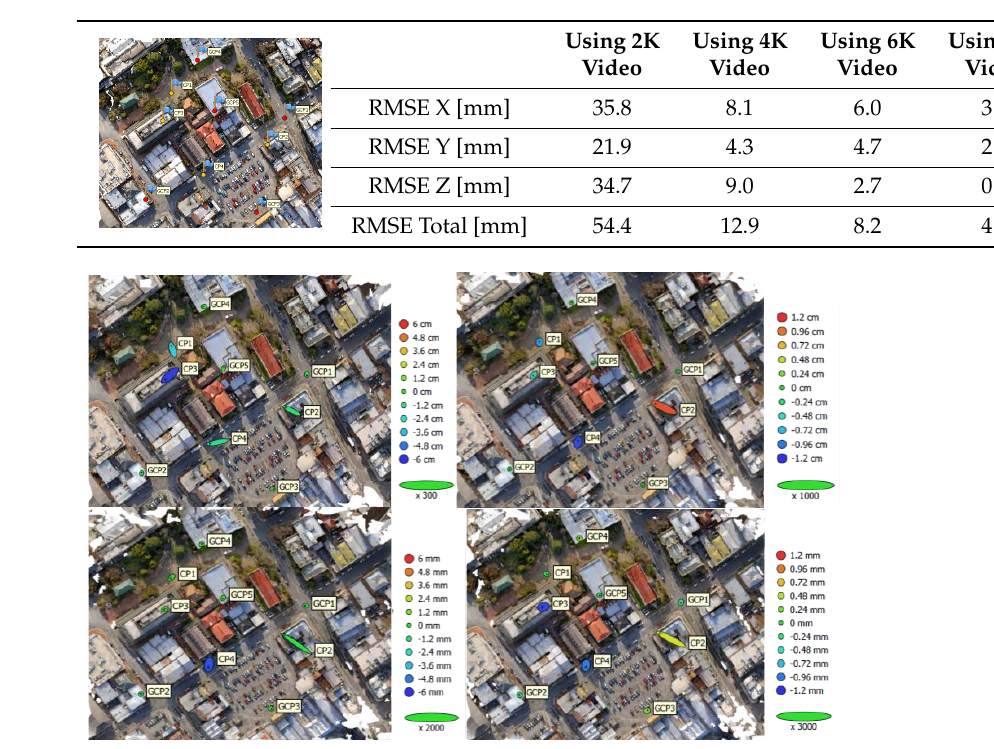
Figure 11. The top view of the checkpoints and GCPs exaggerated error ellipses visualization of the area in the first test at the four drone video resolutions. The error in Z is represented by ellipse color while XY errors are represented by ellipse shape using the Metashape tool.